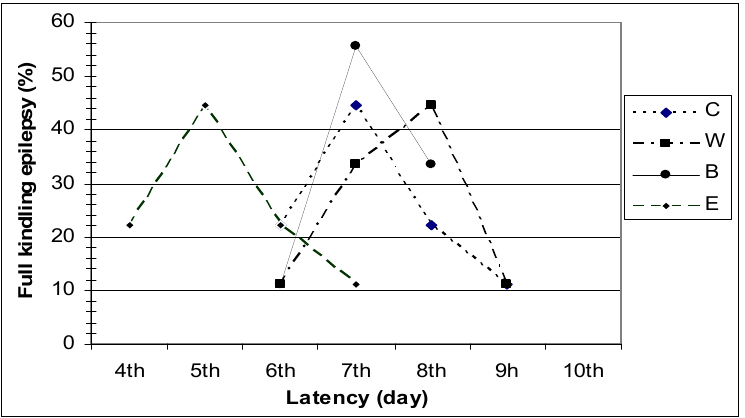
Figure 1. Latency period for the development of full kindling